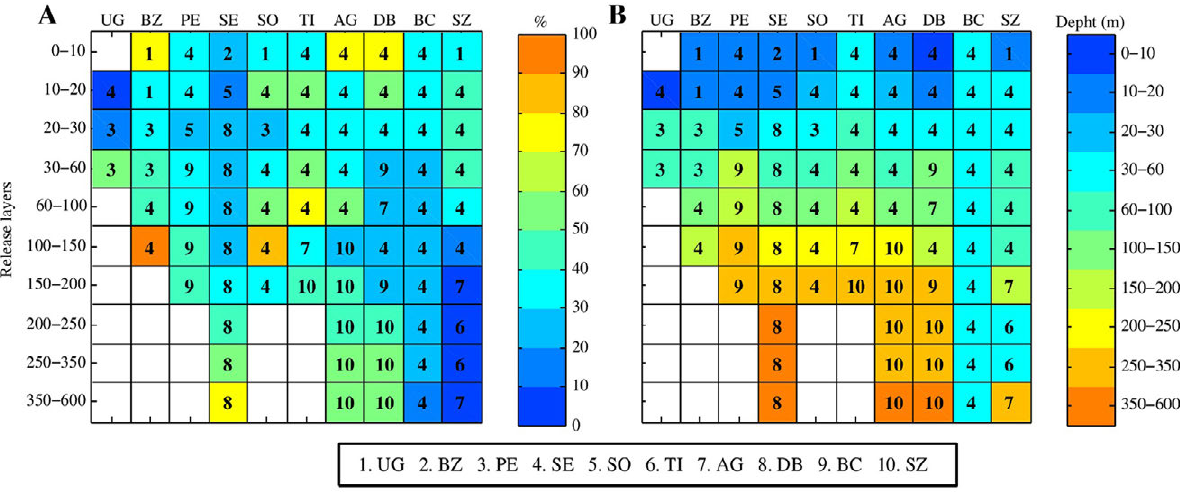
Fig. 13. – A, maximum catchment matrix, showing the cells for each released area and layer that had the highest percentage of particles, after eight weeks, excluding the diagonal elements of the connectivity matrices and indicated with digits; see box located at the bottom of the figure. B, final average depth matrix associated with the maximum catchment